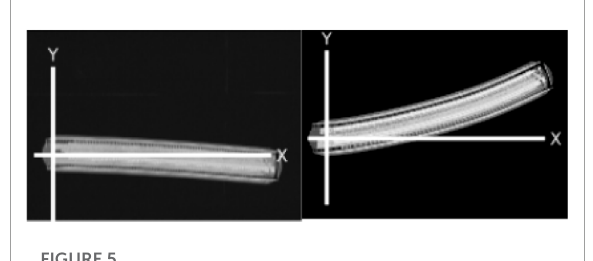
FIGURE 5 Trajectories of two different physical robots, A (left) and F (right), moving forward for 30 s with a speed of 0.02